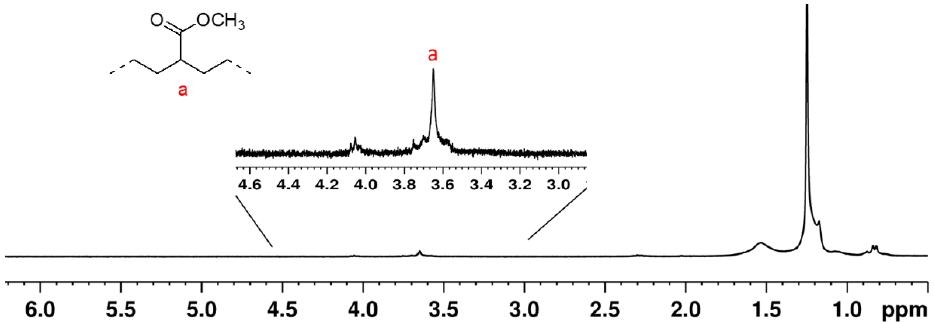
1. The copolymer sample from run 3 was extracted with boiling pentane as above, and